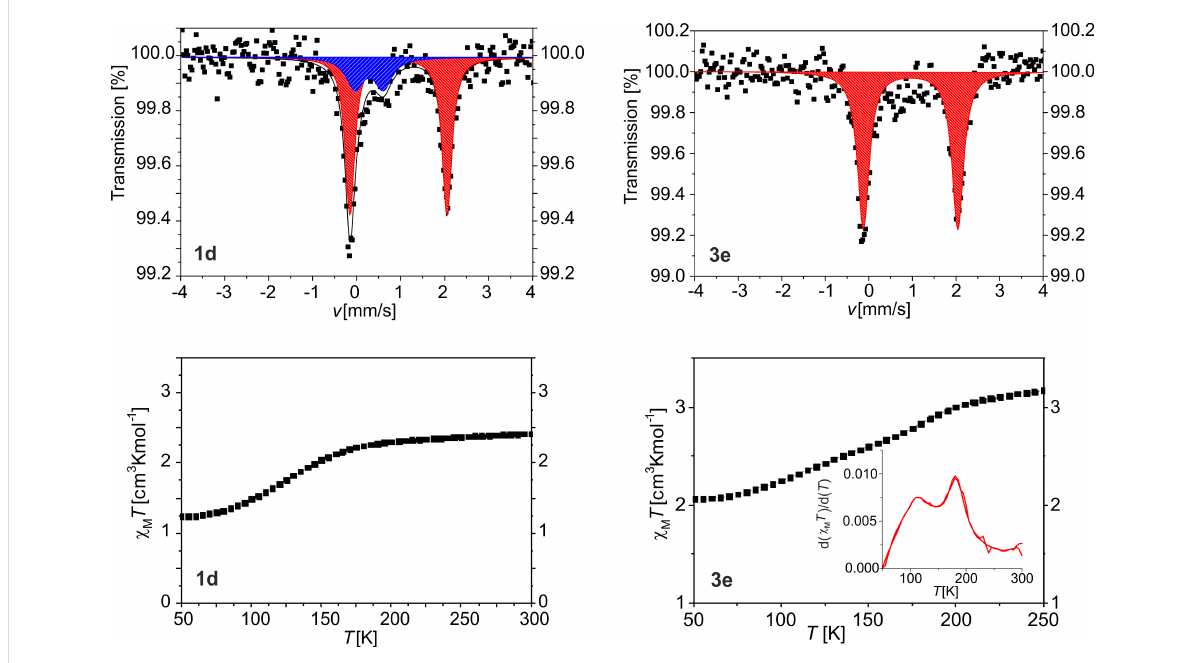
Figure 3: Characterisation of the magnetic properties of 1d and 3e Top: Mössbauer spectra of 1d (left) and 3e (right). Bottom: Magnetic susceptibility data displayed as χ M T vs T of 1d (left) and 3e (right). In the case of 3e in the inset the first derivative of the χ M T vs T plot is given to illustrate the steps in the transition curve more